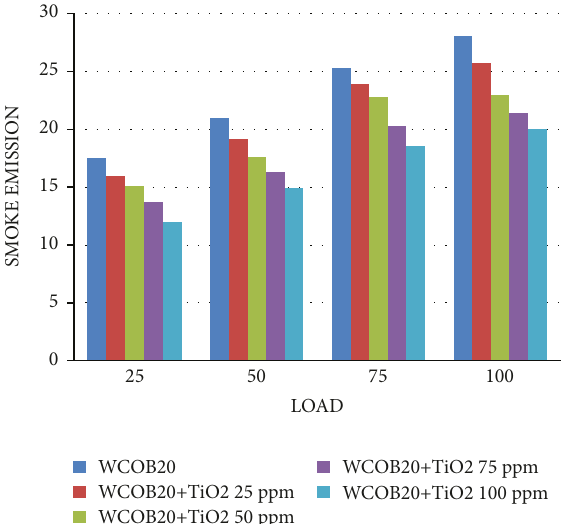
Figure 11: Variation of smoke opacity with respect to load.